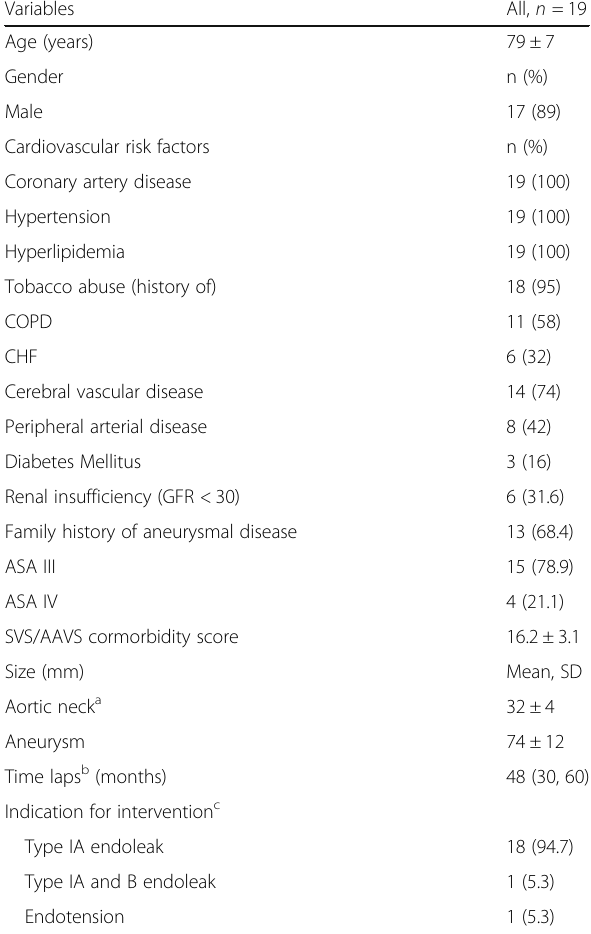
Table 1 Patient demographics and cardiovascular risk factors